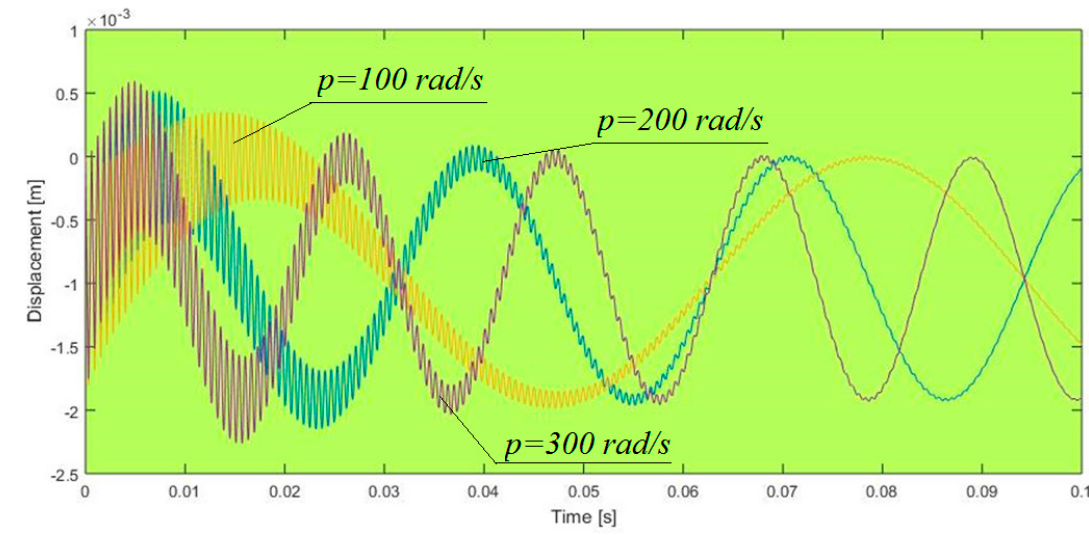
Figure 13. Excitation frequency 50 / π , 100 / π , 150 / π .